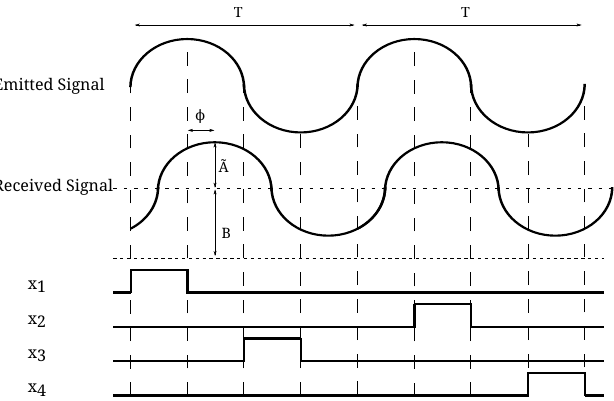
Figure 6. Sketch of the measurements needed in voltage mode-modulated ToF. Table 2. Number of accumulations for different ToF